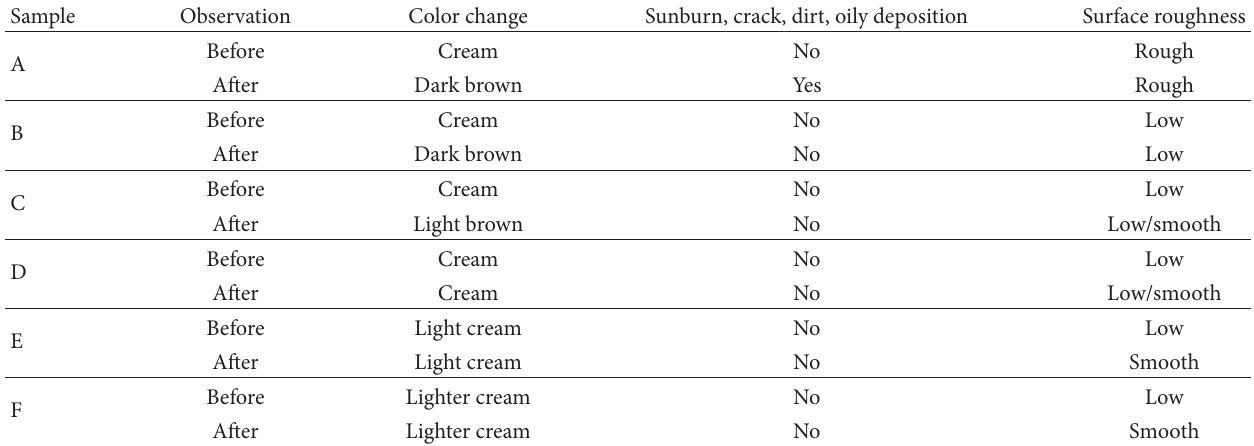
Table 6: Observation on uncoated and coated LC samples before and after exposure to sunlight and overnight humidity.